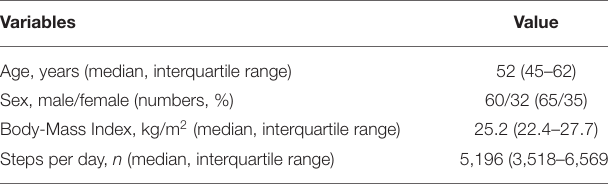
TABLE 1 | Patient characteristics ( N = 92).